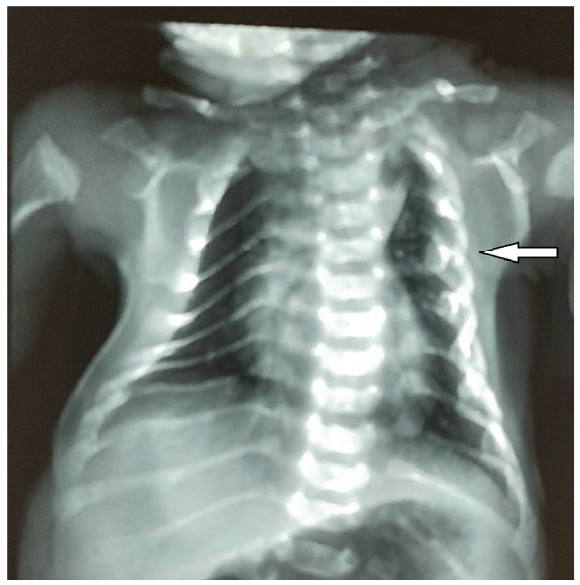
Figure 3: Diffuse osteopenic changes and fractures of ribs (marked more on left hemithorax shown by